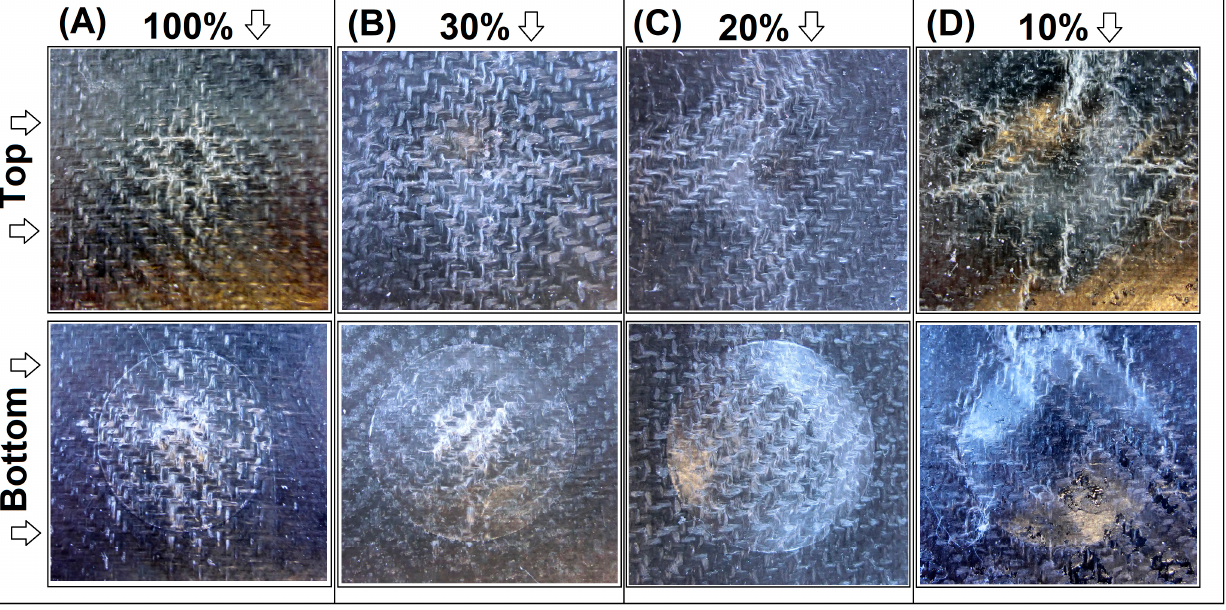
Figure 9. The appearance of the top and bottom surface of the sandwich sample after the drop weight test. GPET/CF samples: ( A ) 100% infill, ( B ) 30% infill, ( C ) 20% infill, and ( D ) 10% infill.